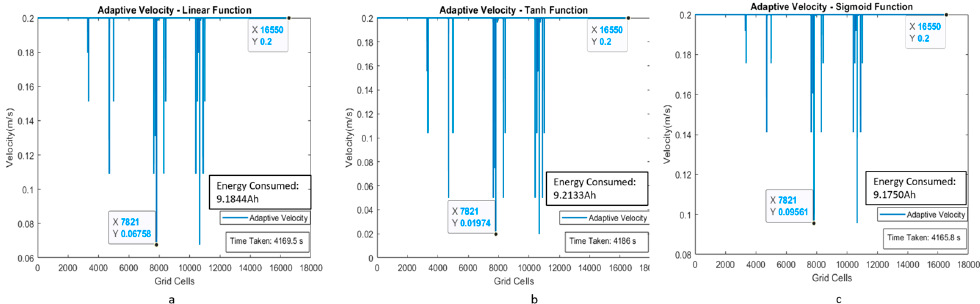
Figure 17. Adaptive velocity behavior model with linear, tanh, and sigmoid functions with velocity corresponding to the grid cells of the map for scenario